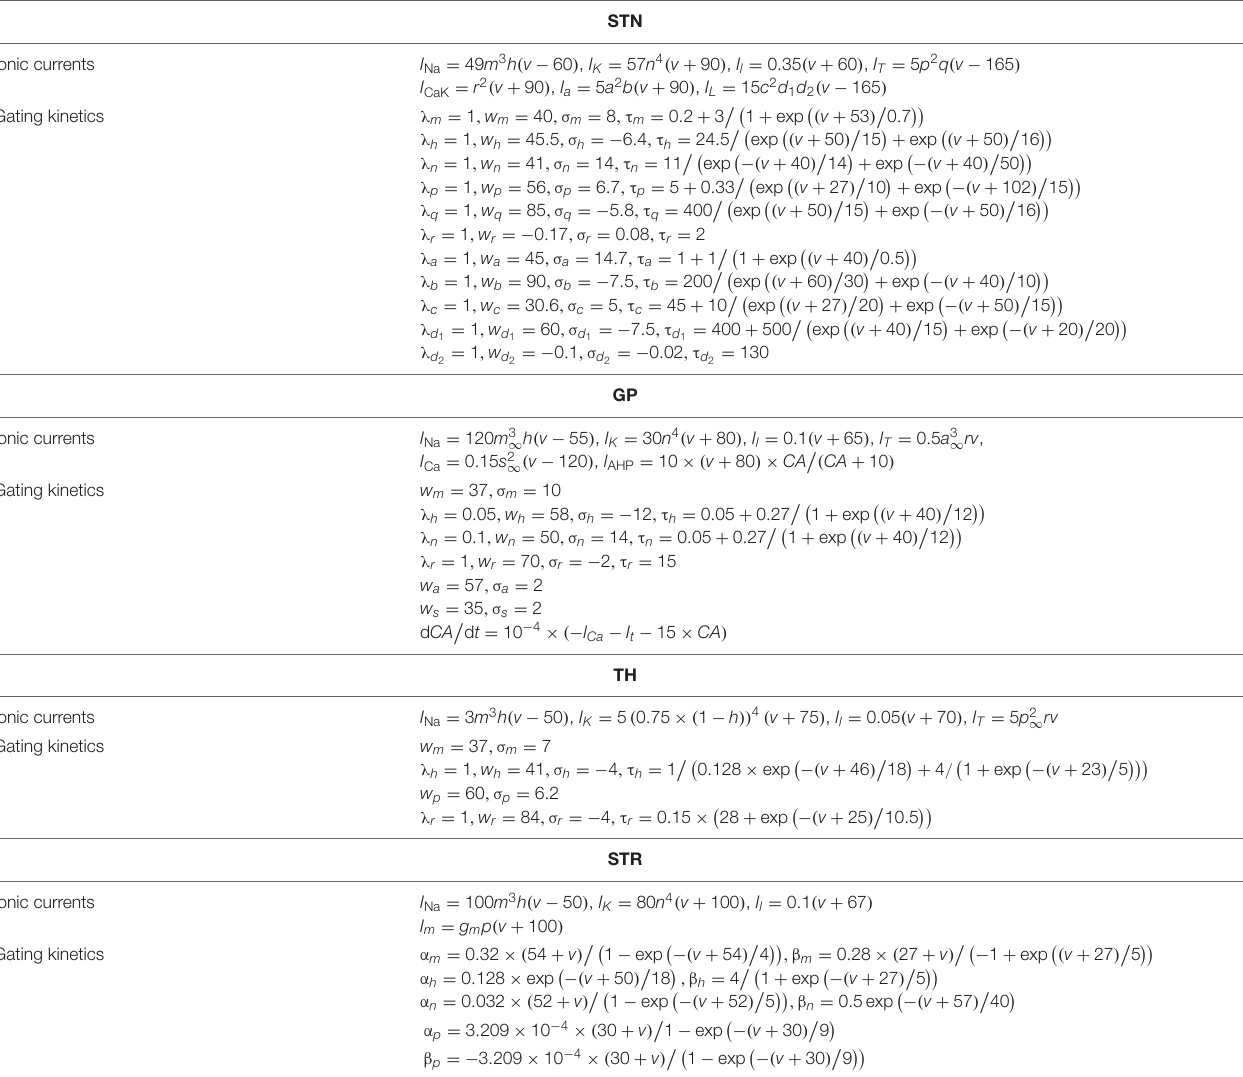
TABLE 1 | Equations and parameters for subthalamic nucleus (STN), globus pallidus (GP), TH, and striatum (STR) model neurons.